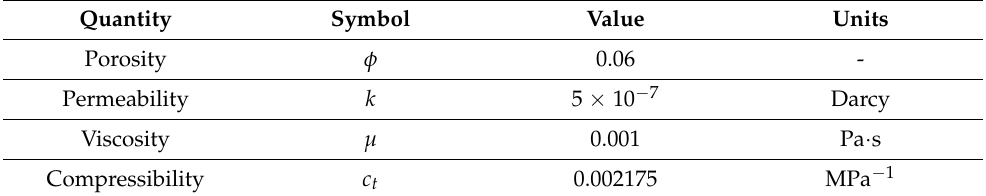
Table 1. Values assumed for computing pressure transient advance (Figure